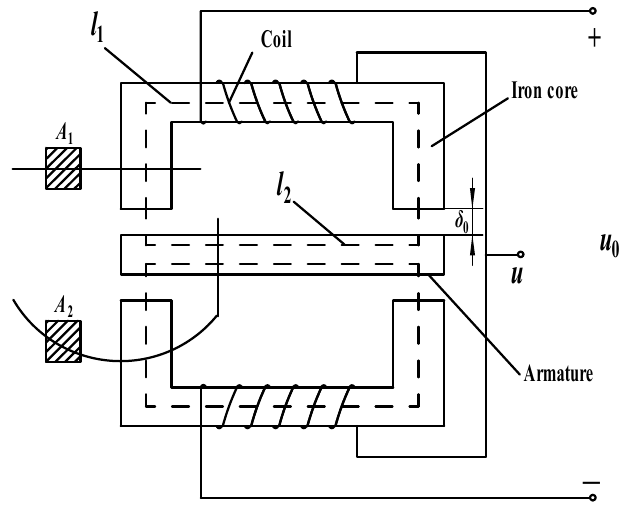
Figure 1. Schematic diagram of the differential inductive sensor structure.